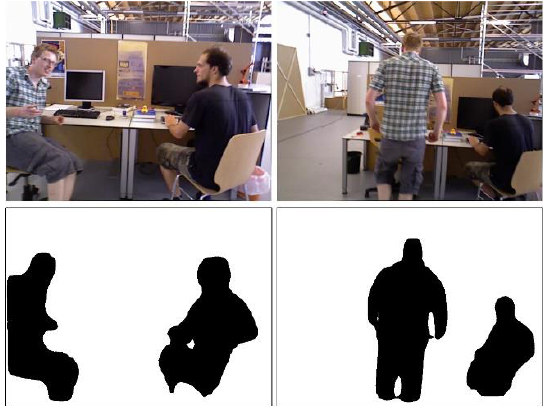
Figure 3. The upper line is the RGB images in TUM dynamic dataset [29], and the bottom line is the indoor pedestrians segmentation results by Mask R-CNN, where the black parts are dynamic regions. The pixel value of black regions (dynamic regions) is 0. The pixel value of white regions (static regions) is 1.